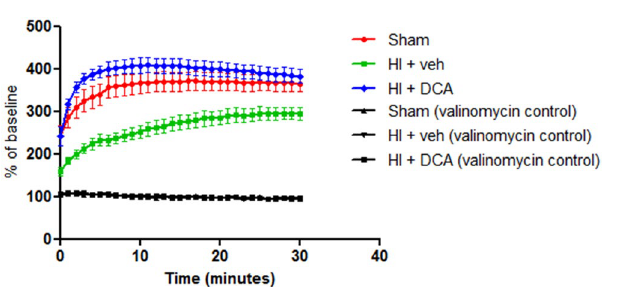
Figure 6. Mitochondrial potential following HI and DCA treatment. JC1 Staining Assay carried out using isolated mitochondria as per the protocol (Sigma, MO). Valinomycin used as an internal control. All samples were tested in triplicates. * Indicates p < 0.05 for HI + Veh compared to Sham. (n =